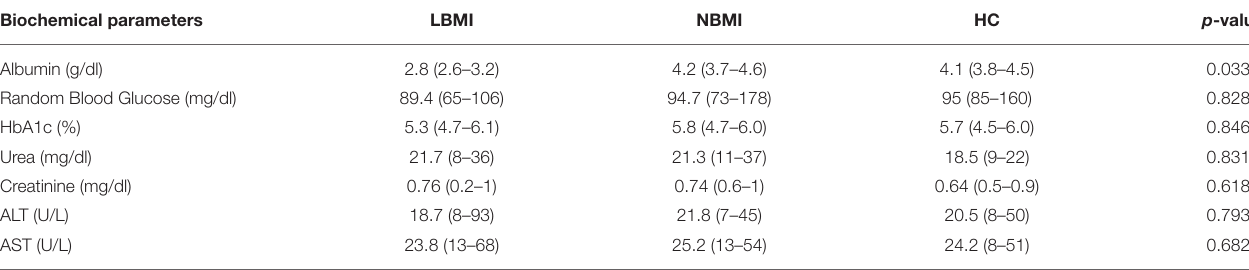
TABLE 1B | Biochemical parameters of the study population. Biochemical